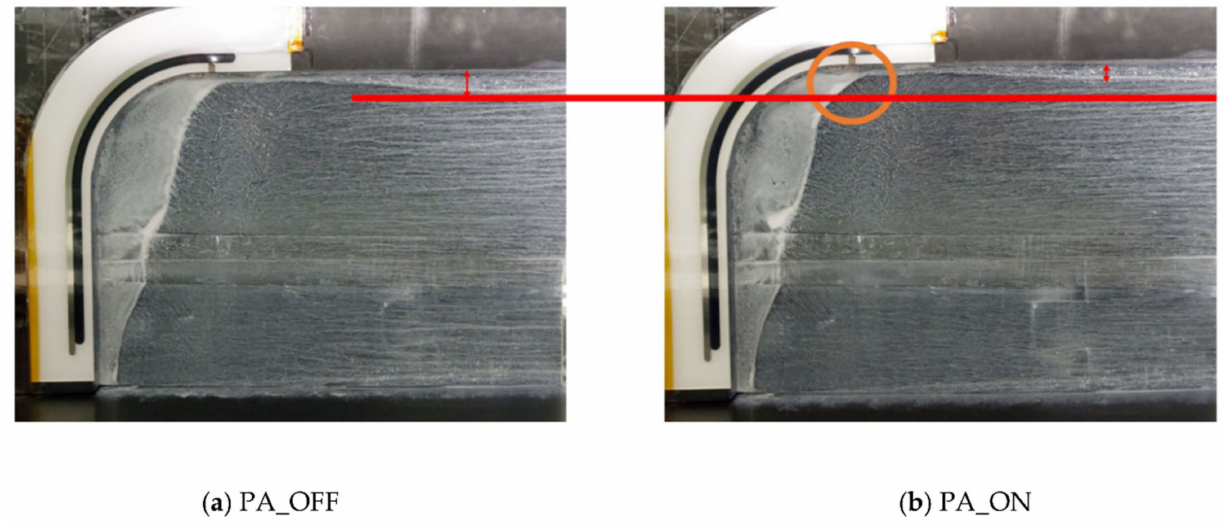
Figure 29. Oil flow visualization (Vertical Vortex).